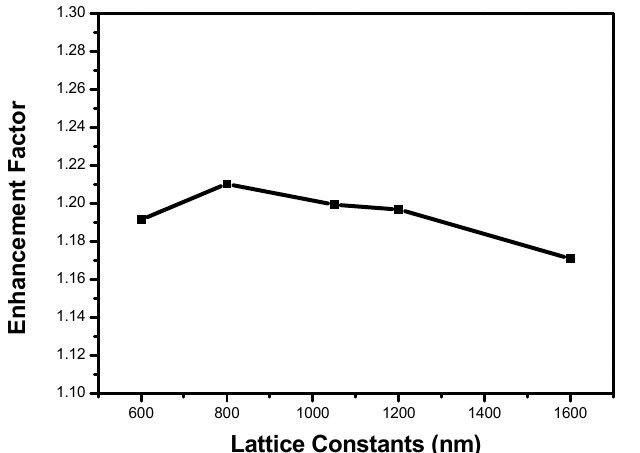
Figure 5. The calculated enhancement factors of the TE-polarized integrated transmission on the lattice constant.